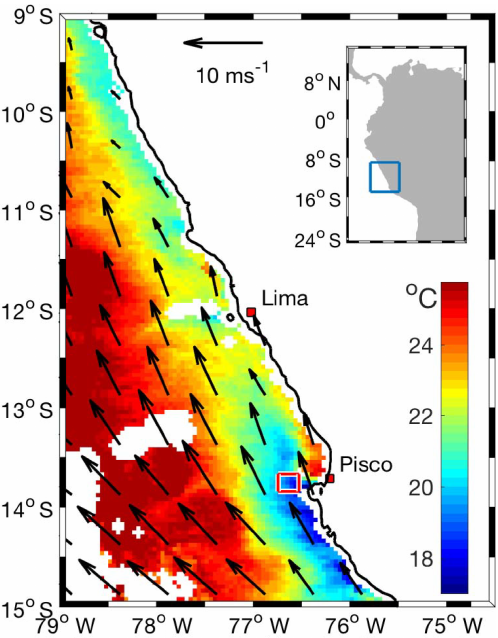
Figure 1. MODIS SST (color) and ASCAT (Advanced Scatterome- ter) wind field (arrows) off the Peruvian coast on 16 February 2013. The small red box shows the study region off